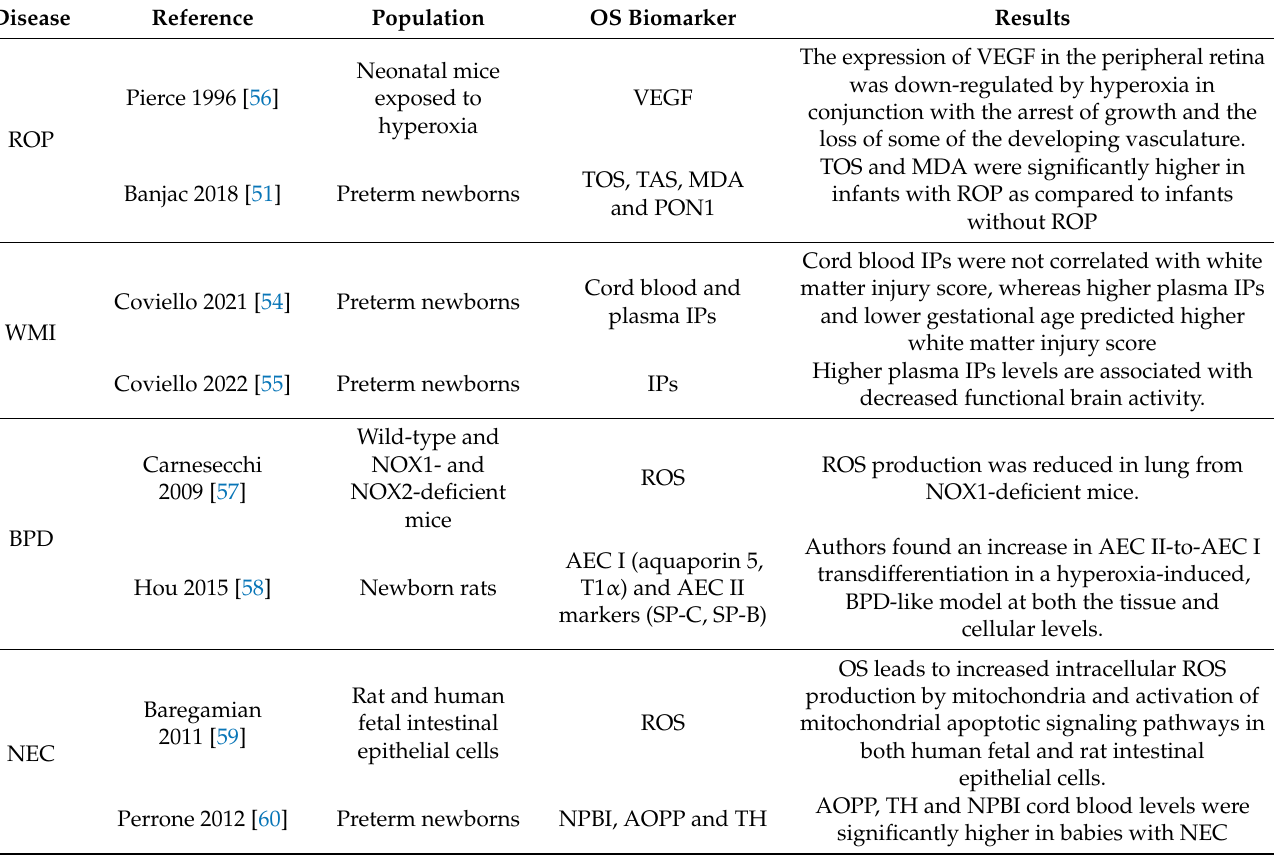
Table 1. List of the included papers. Table legend: OS (oxidative stress); ROP (retinopathy of prematurity); VEGF (endothelial growth factor); TOS (Total oxidative status); TAS (total antioxidant status); MDA (malondialdehyde); PON1 (paraoxonase 1); PVL (periventricular leukomalacia); IPs (isoprostane); BPD (bronchopulmonary dysplasia); NOX (NADPH oxidase); ROS (reactive oxygen species); AEC (alveolar epithelial cell); SP (surfactant protein); NEC (necrotizing enterocolitis); NPBI (non-protein bound iron); AOPP (advanced oxidation protein products); TH (total hydroperoxides; PDA (patent ductus